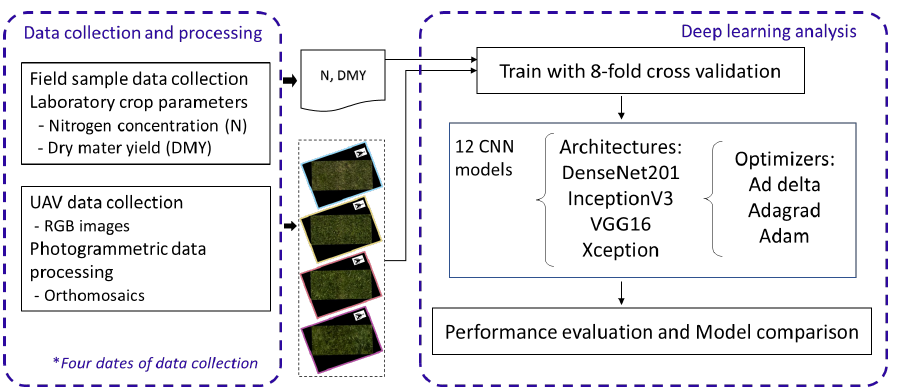
Figure 1. Workflow of the main steps performed in this